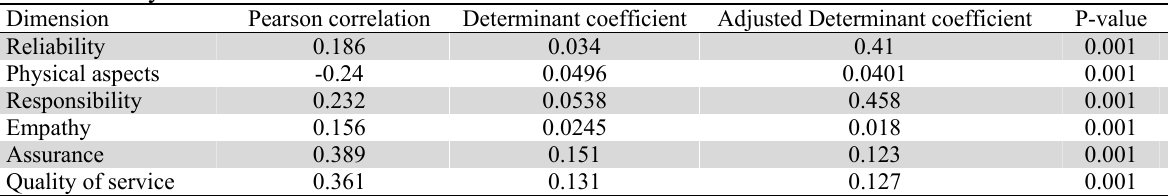
The summary of Pearson correlation test Dimension